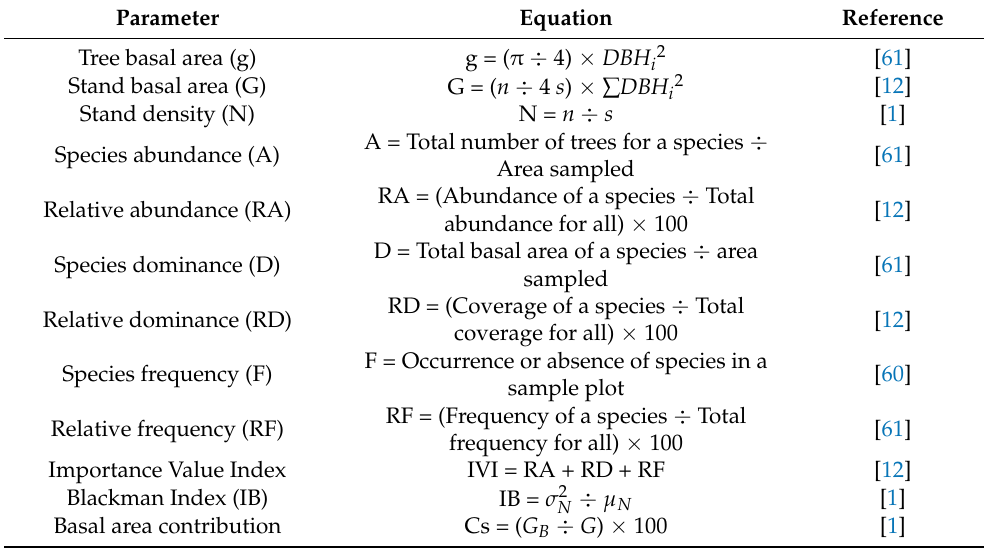
Table 2. Utilized equations for the calculation of dendrometric and structural parameters of the tree species collected in the Dinder Biosphere Reserve, Sudan, over a period of one year in sites of different anthropogenic pressure. DBH i is the diameter at breast height of the i th tree (cm), n represents the total number of trees in the sample, and s is the area sampled. σ 2 and µ N represent the variance and N mean, respectively, of the B. aegyptiaca tree density of the site. Density is the number of stems per sampled area. G B is the basal area of B. aegyptiaca trees while G is the basal area for all tree species encountered per site (stand basal